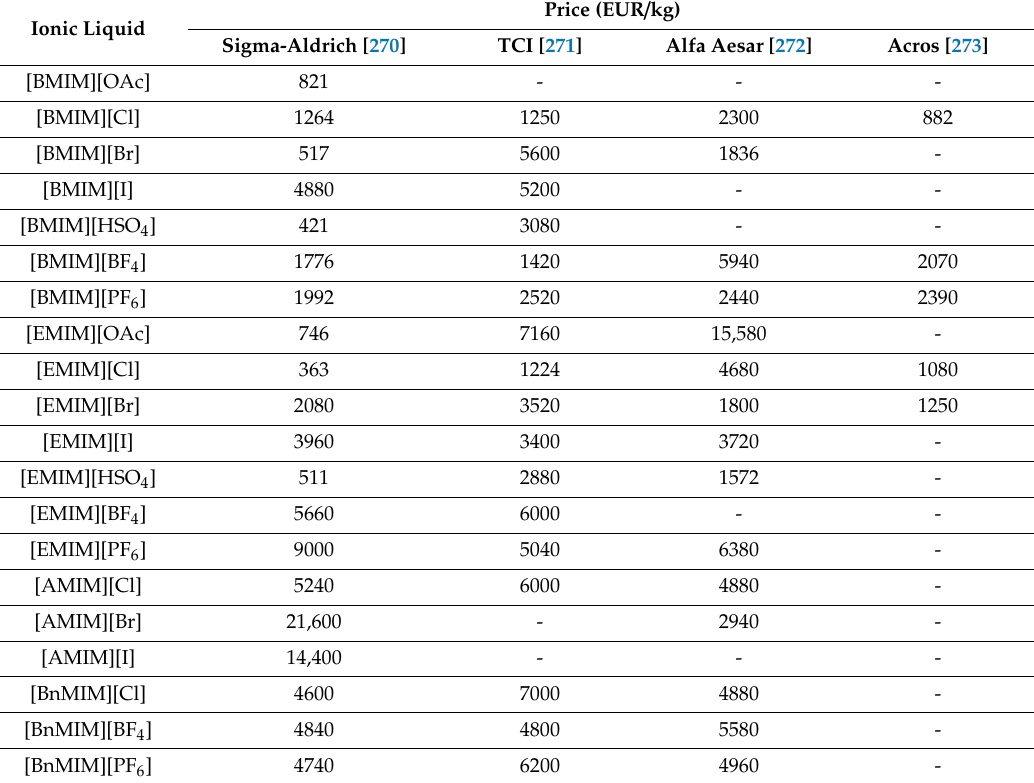
Table 5. The prices of the most commonly used ionic liquids for wood and cellulose processing. The prices are not enlisted for comparison as they are based on products of di ff erent purities (95–100%) and sizes (5–1000